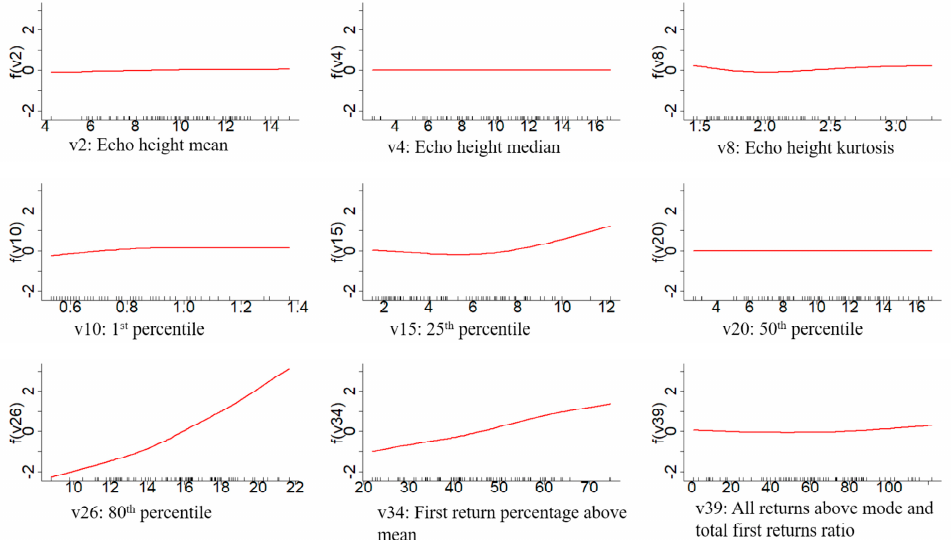
Figure 6. Each panel shows the relationship of the variable with nonzero coefficients (X-axis) in the GAMSEL model for volume estimation with the functions for the last value of the lambda (Y-axis).